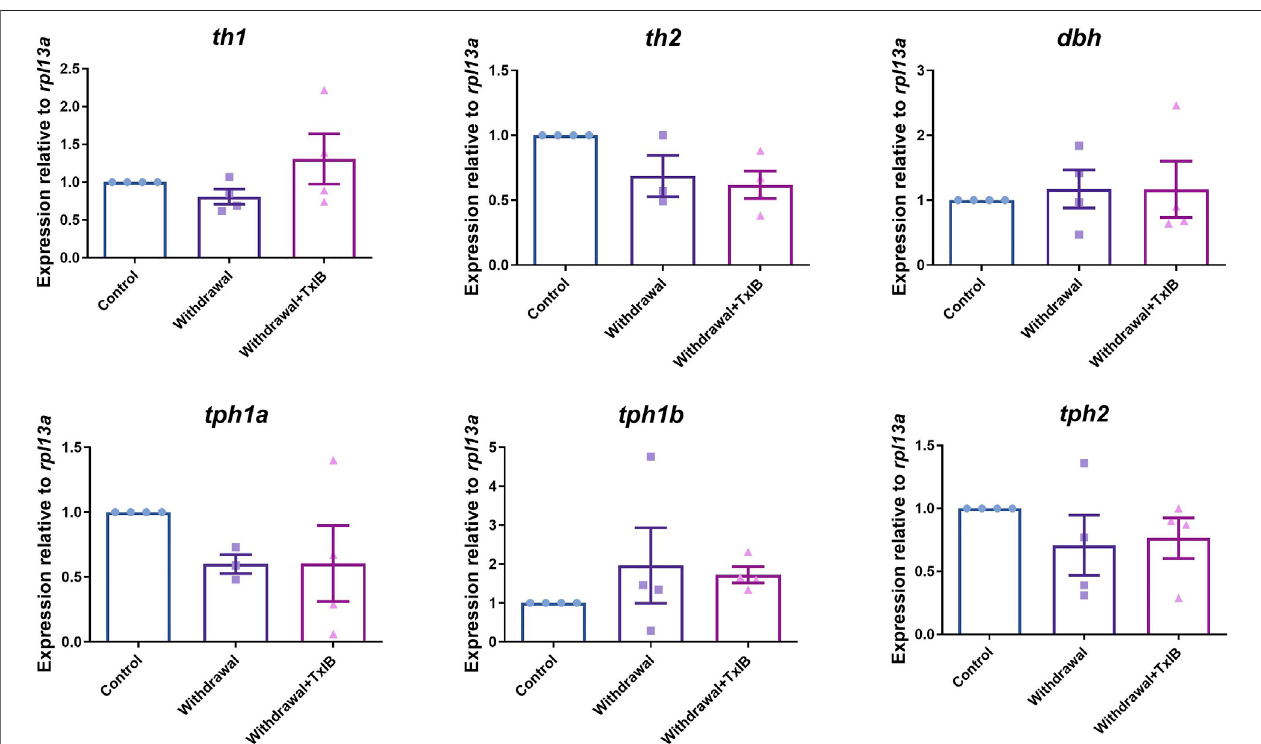
FIGURE 3 | mRNA expression of rate-limiting enzymes in the synthesis of monoamine neurotransmitters, th1 , th2 are two isoforms of the rate-limiting enzyme of dopaminesynthesis, dbh isthe rate-limitingenzymeofnoradrenaline synthesis, tph1a , tph1b ,and tph2 arethree isoformsofthe rate-limiting enzymeof5-HT synthesis. TxIB concentration of 1 mg/kg was used. Data are mean ± SEM of 4 zebra fi sh per group. One-way ANOVA followed by Tukey ’ s multiple comparisons test was performed.